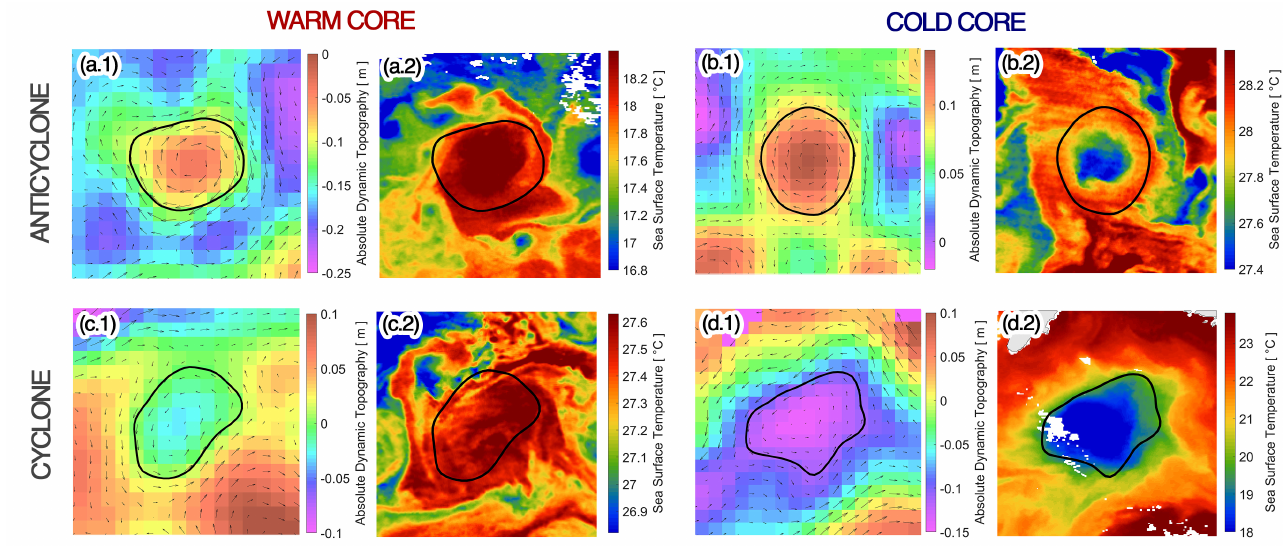
Figure 1. Samples of eddy-induced SST anomalies for a ( a ) Warm Core Anticyclone, ( b ) Cold Core Anticyclone, ( c ) Warm Core Cyclone, ( d ) Cold Core Cyclone. On the leftmost panels numbered with ( 1 ), the velocity vectors and the characteristic contour, computed by the AMEDA algorithm (black line), are superimposed on the Absolute Dynamic Topography. On the rightmost panels numbered with ( 2 ), the characteristic contour (black line) is superimposed on the patches of Sea Surface Temperature field centred on the detected eddy. Image patches are of side 5 R max , which are chosen in order to include the temperature of